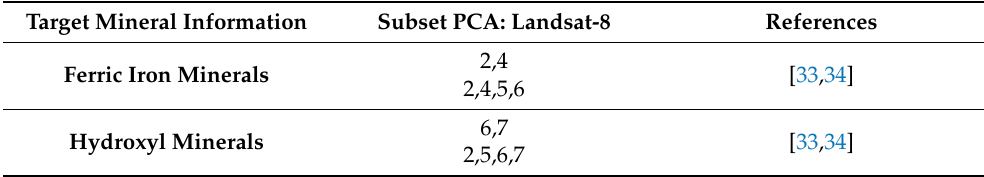
Table 4. Chosen subsets for the selective PCA for Landsat-8 imagery dated 25 February 2021. Target Mineral Information Subset PCA: